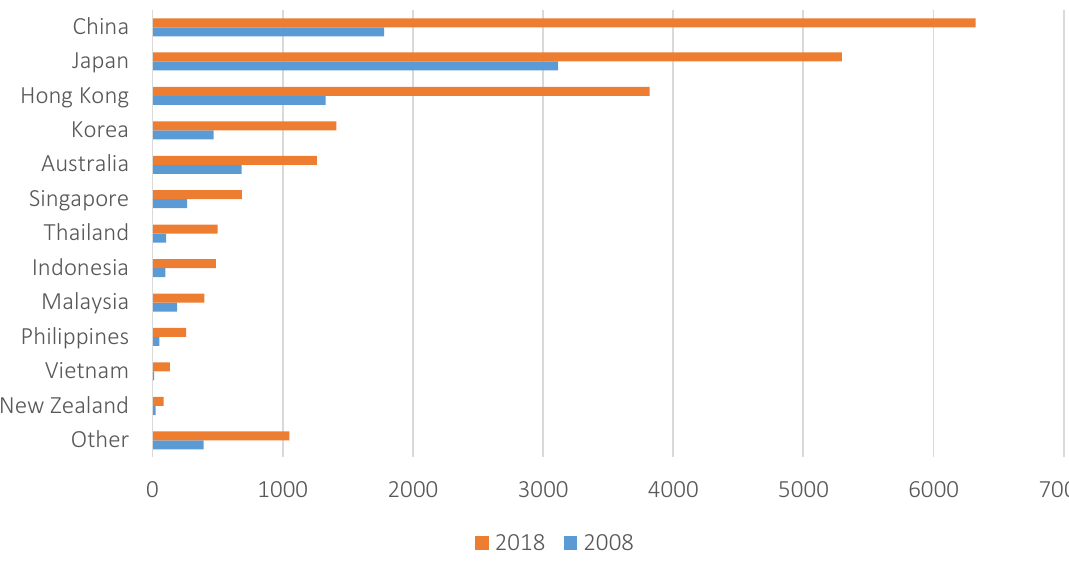
Figure 1. Stock market capitalization at the end of 2008 and 2018 (USD billion)